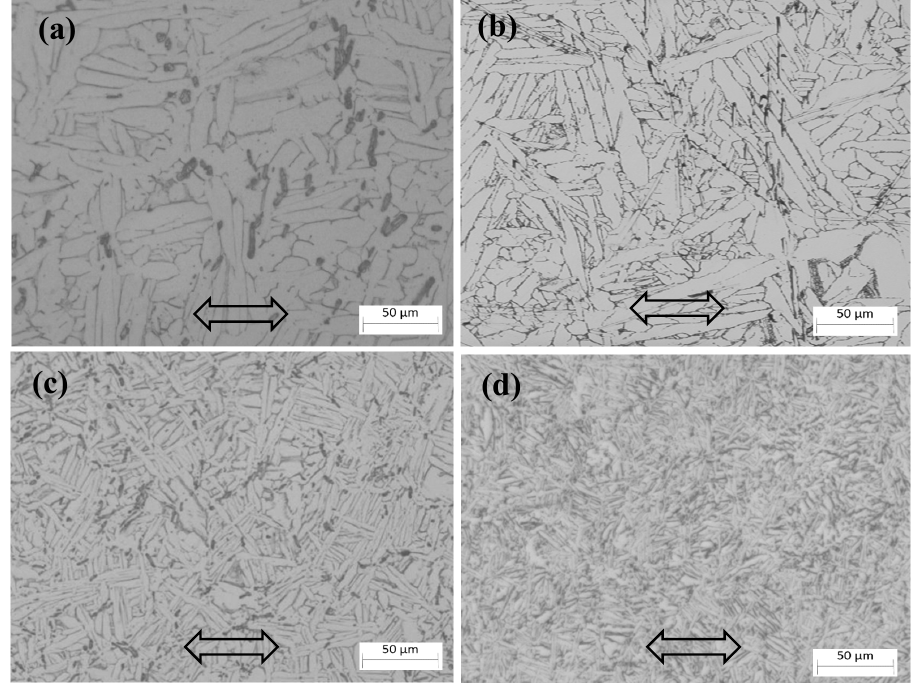
Figure 7. Microstructure of the composite with different deformation ratios, λ z: ( a ) 1.0, ( b ) 0.39, ( c ) 0.26, ( d ) 0.14, arrows showing loading direction during tensile tests.